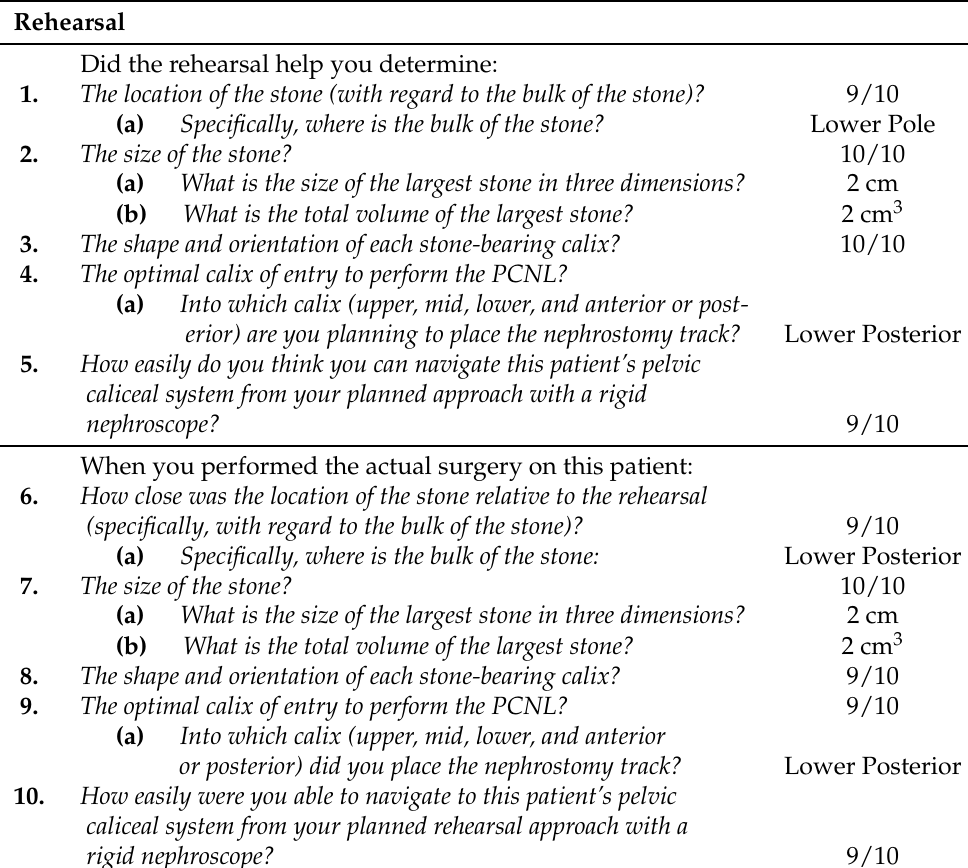
Table A3. Postoperative Assessments: